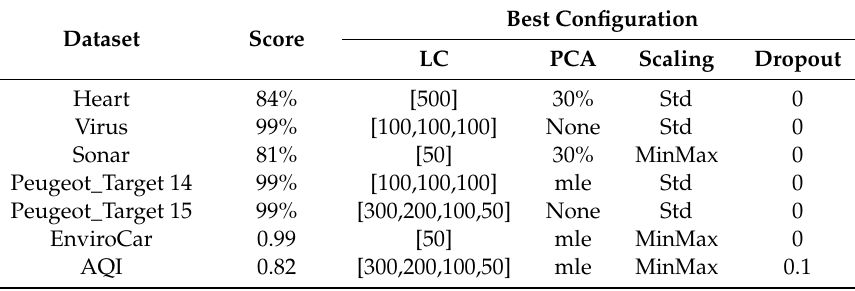
Table 31. Tanh activation function